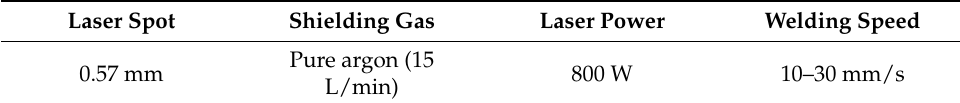
Table 2. Laser welding parameters.